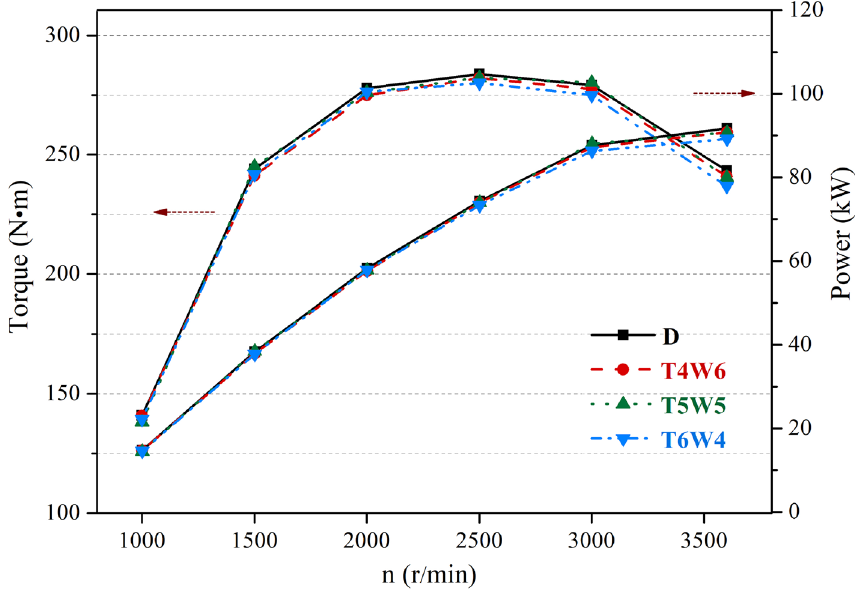
Figure 2. Power performance of three kinds of coal-based diesel blends and petroleum diesel.